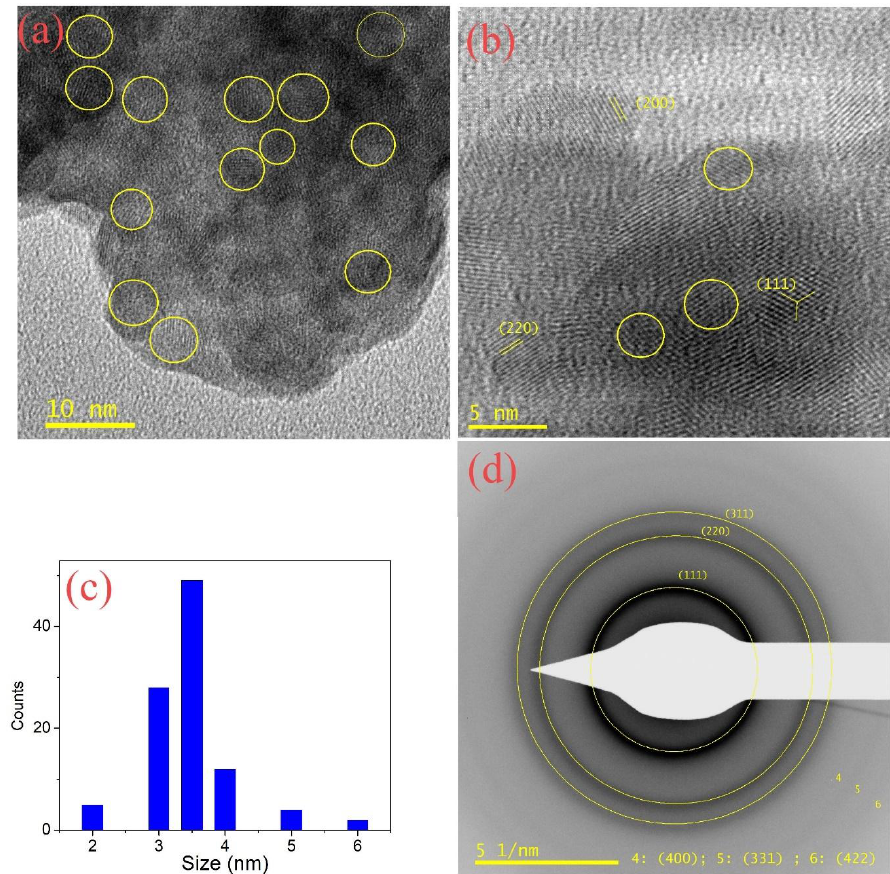
Figure 4. HRTEM images of the S10 sample: ( a ) HRTEM with a scale bar 10 nm; ( b ) HRTEM with a